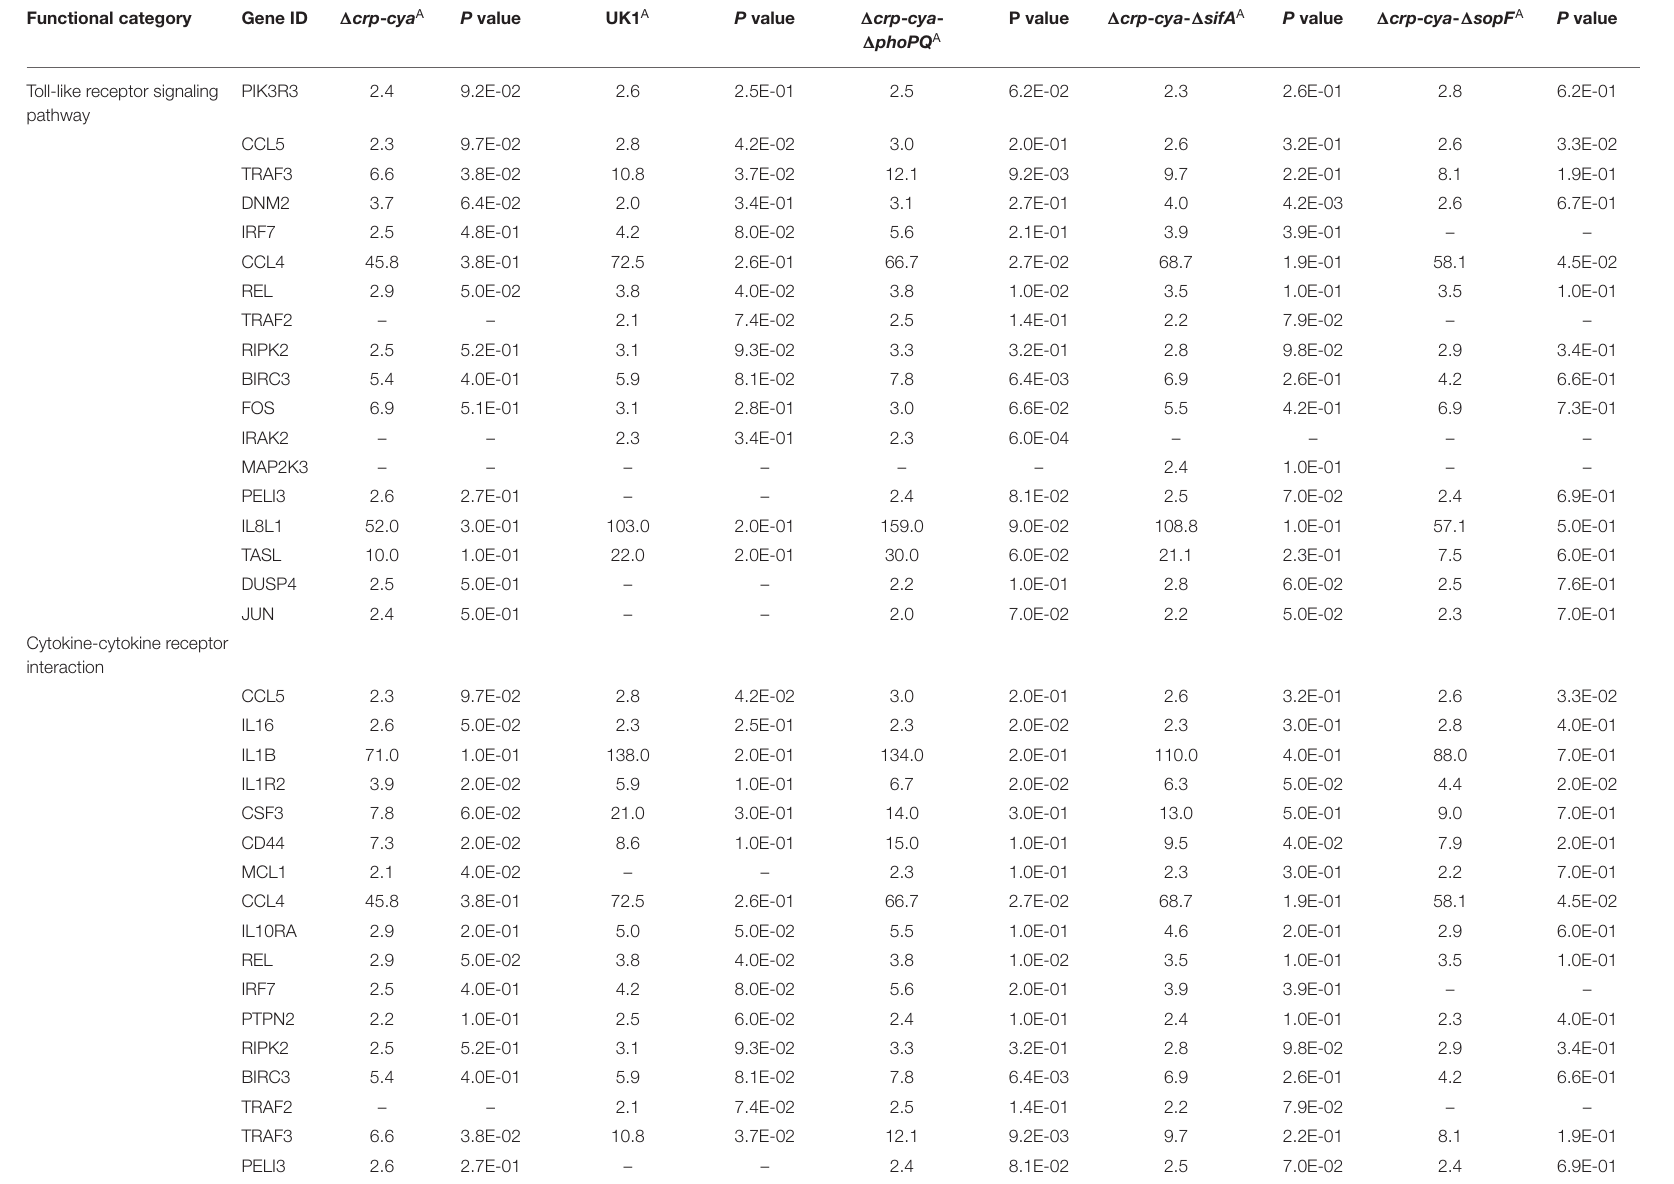
TABLE 3 | Genes upregulated in primary macrophages infected with S. Typhimurium UK1, 1 crp - cya , 1 crp - cya - 1 phoPQ , 1 crp - cya - 1 sifA and 1 crp - cya - 1 sopF